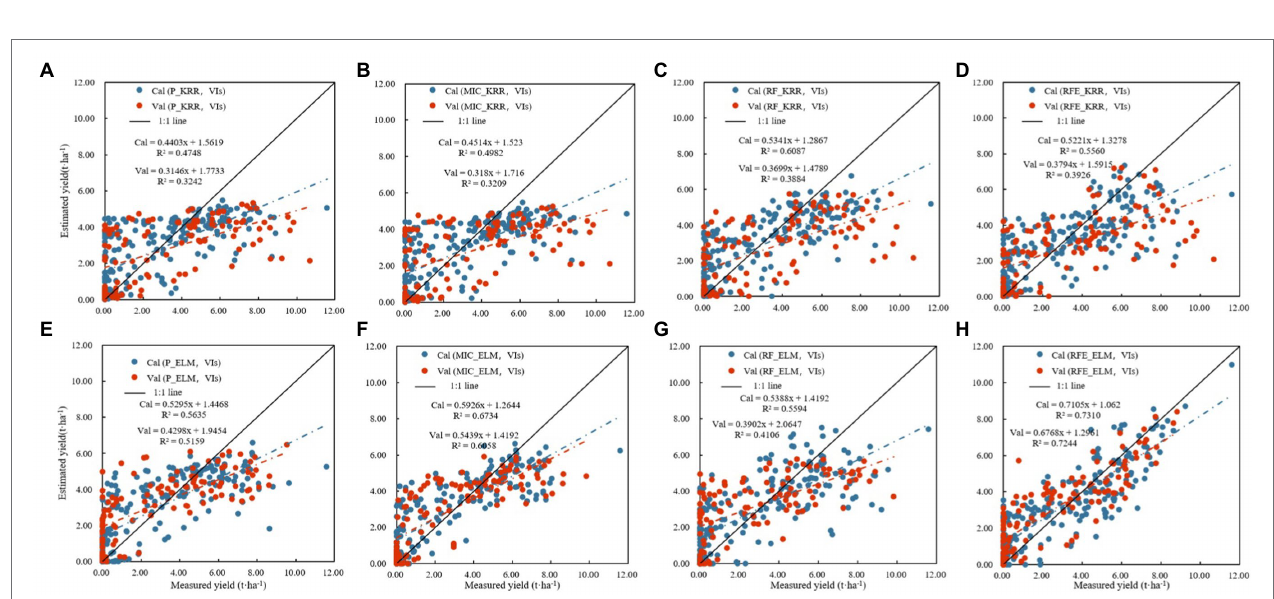
FIGURE 6 | Monitoring model result of cotton yield based on the visible vegetation indices (Note: P denotes feature parameters screened out based on Pearson’s correlation coefficient, cal denotes training set; val denotes validation set. (A) Modeling results based on linear regression, (B) modeling results based on nonlinear regression).